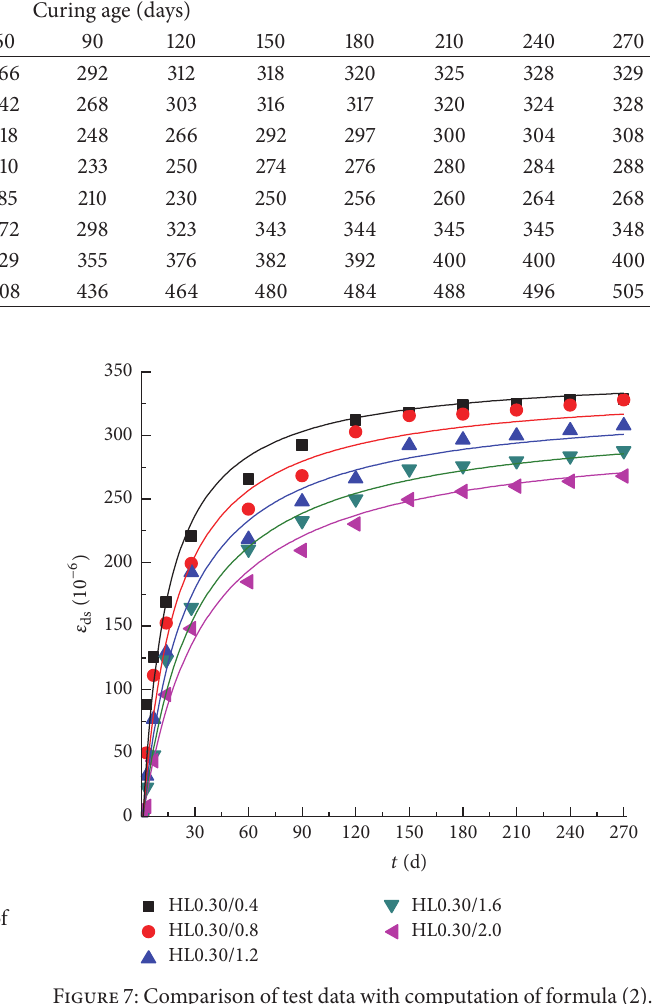
Table 9: Test results of drying shrinkage of SFRLAC.